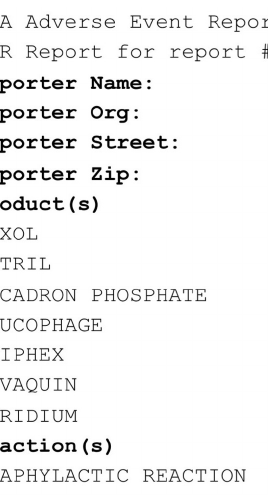
Figure 1. A sample AERS Report with structured data and narrative